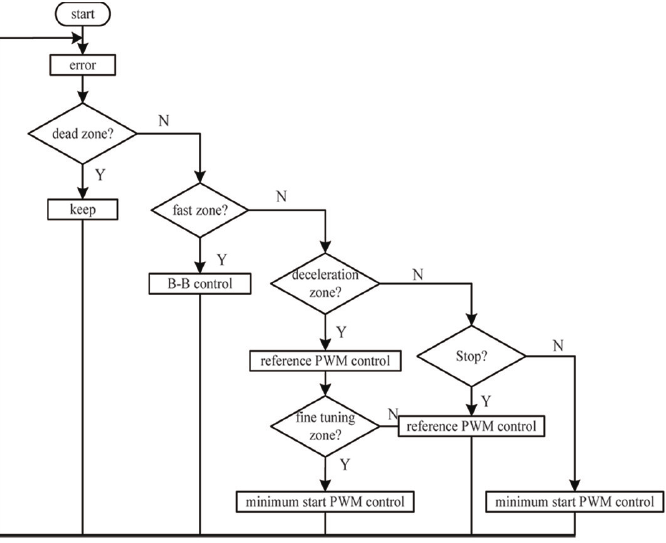
Figure 15. The concrete realization of the optimal control